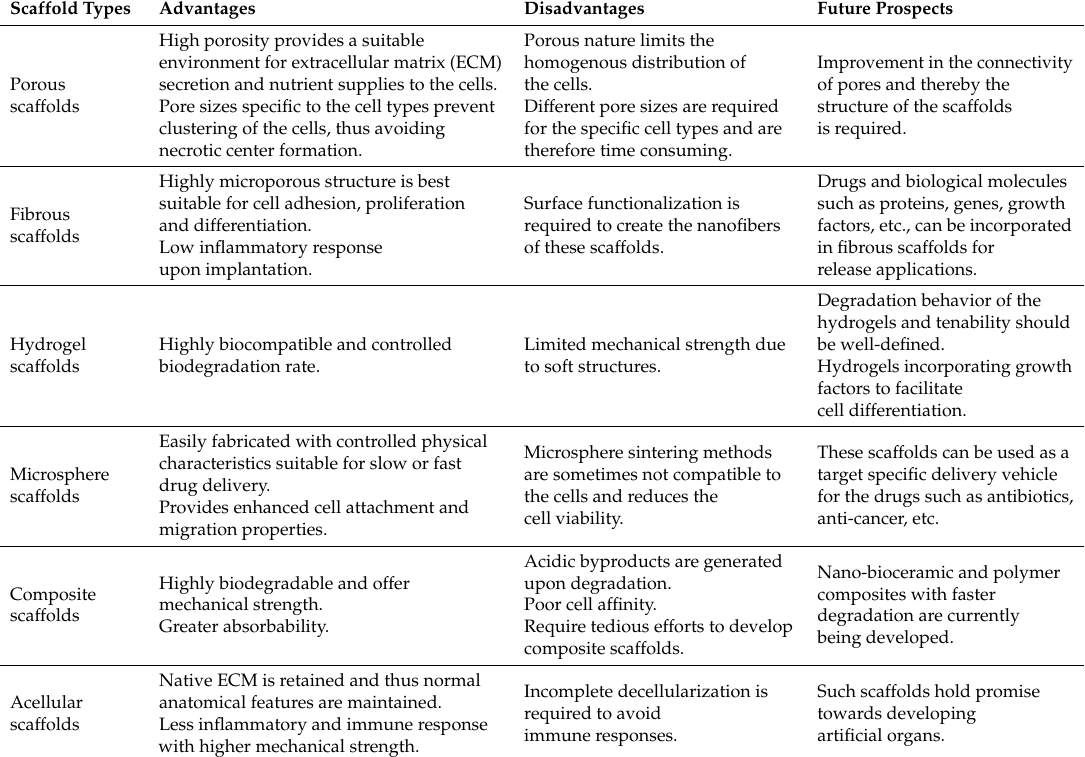
Table 1. Advantages and disadvantages of different scaffolds used in skin tissue